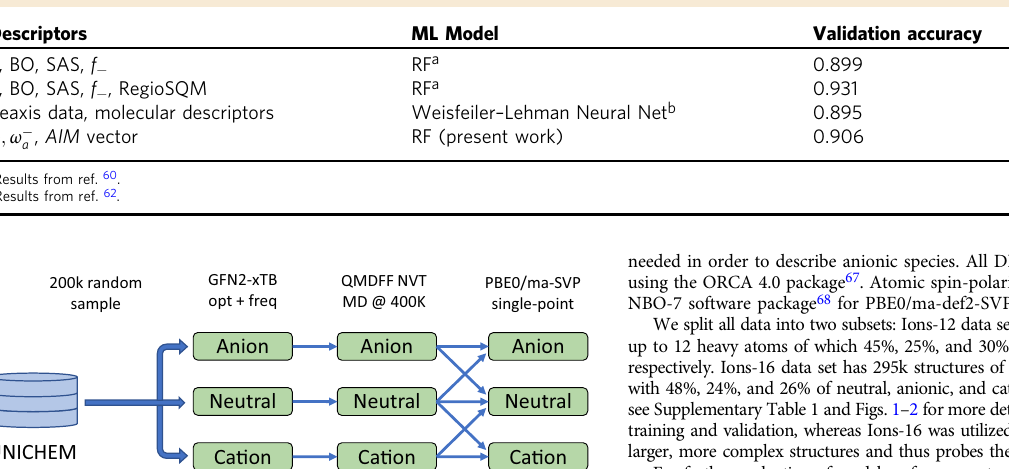
Table 2 Compilation of results for EAS regioselectivity prediction with different approaches.